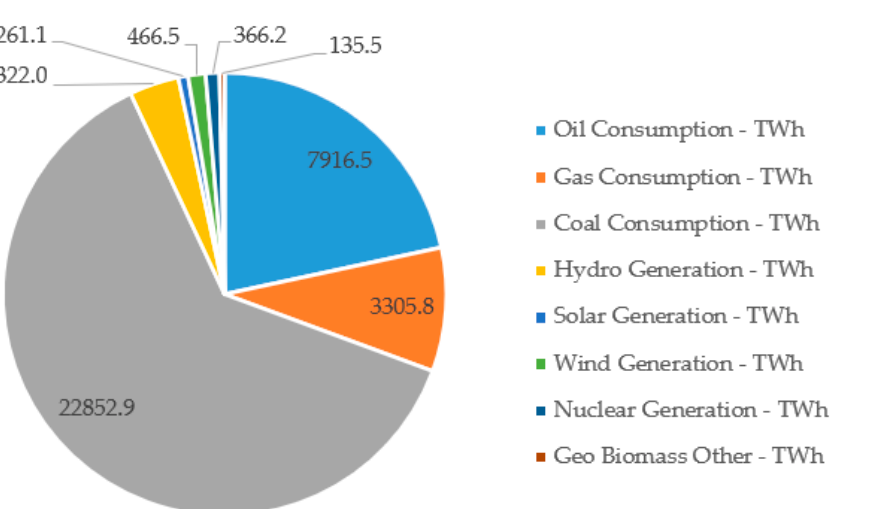
Figure 2. The energy consumption resource distribution in China in 2020 (according to the data source [14]).